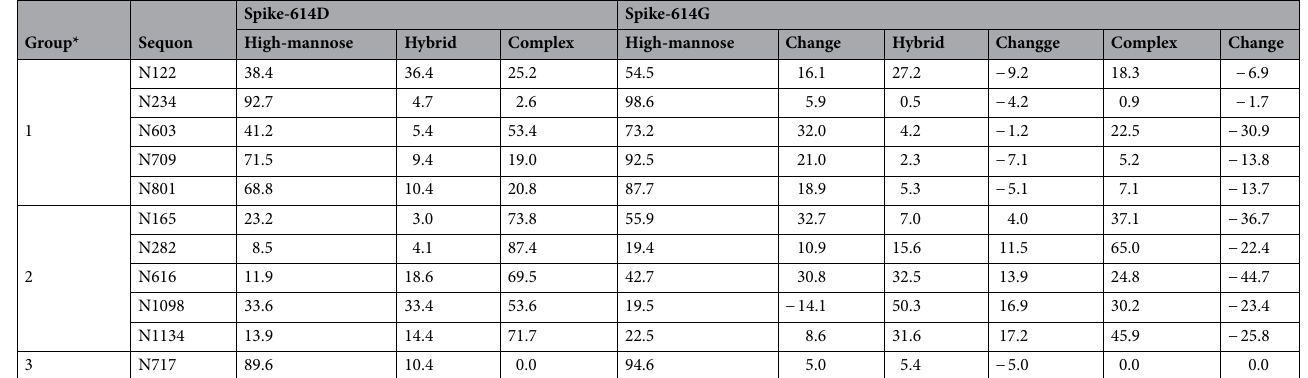
Table 1. Relative abundance (%) of the N-glycans on some of the sequons of the recombinant SARS-CoV-2 Spike D614G mutant and its ancestor. *The sequons in group 1 reduce the hybrid and comple glycans in S-614G. The sequons in group 2 contain reduced complex and increased hybrid glycans in the S-614G. The N717 in the group 3 does not contain complex glycan in both S-614D and S-614G